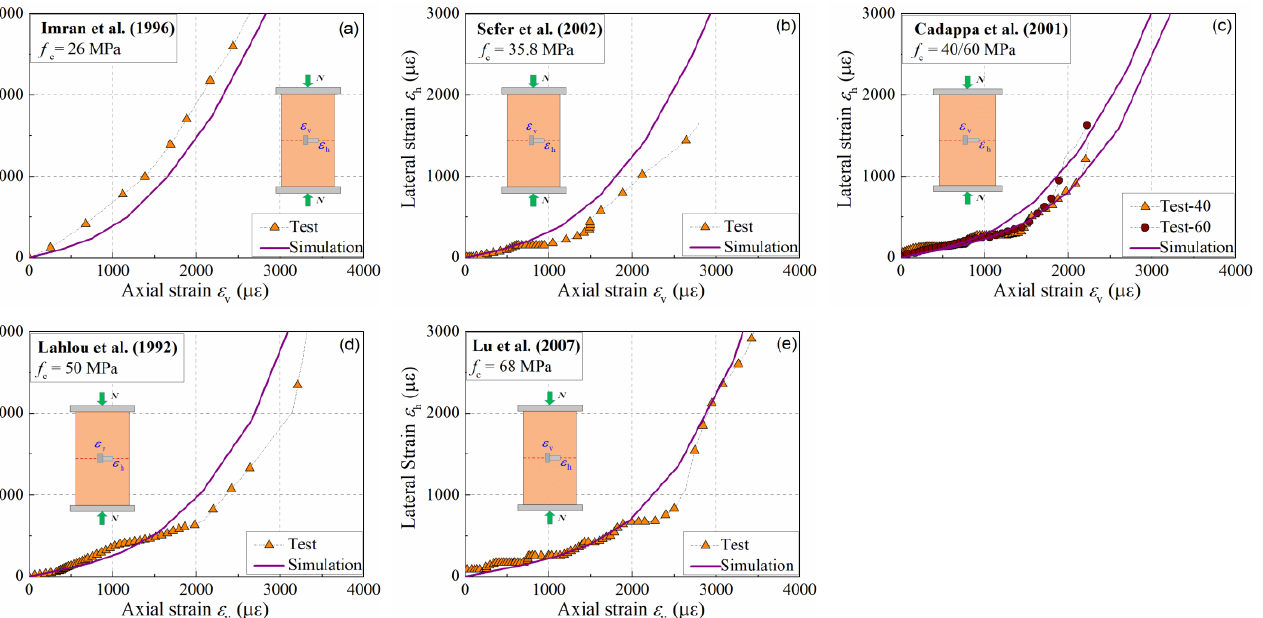
Figure 3. Mechanical properties of concrete specimens with varying mortar strengths: ( a ) stress – strain curve; ( b ) peak values.